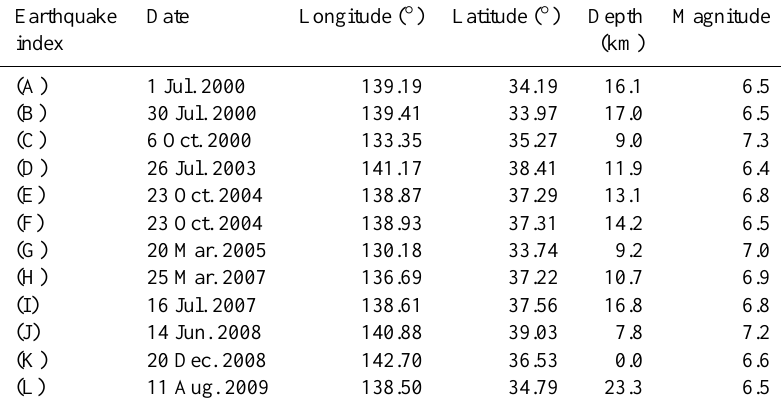
Table 1. Earthquake index assigned to each of 12 large earthquakes with magnitudes larger than M = 6 . 4 with corresponding occurrence date, epicenter (longitude and latitude), depth, and